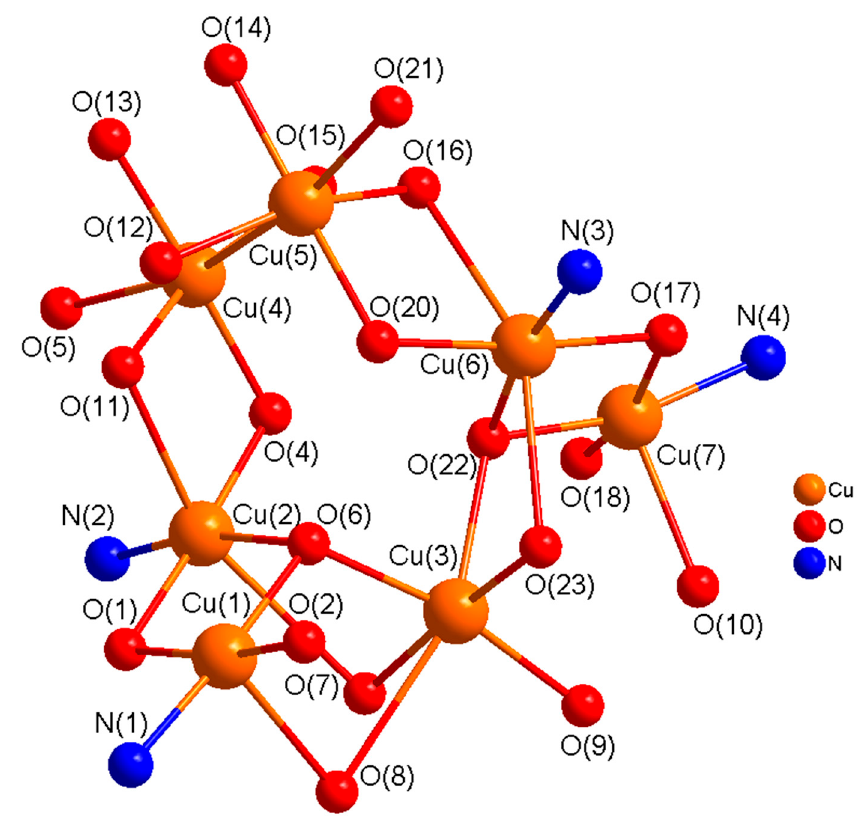
Figure 15. The structure of 5 showing only the copper atoms and the donor atoms.